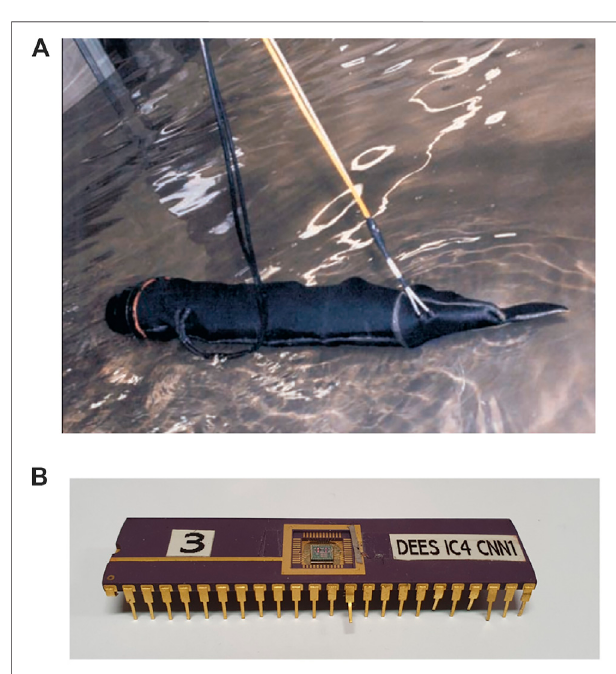
FIGURE 10 | Lamprey-like swimming robot: (A) the robot in operation and (B) CNN chip implementing the lamprey robot CPG.